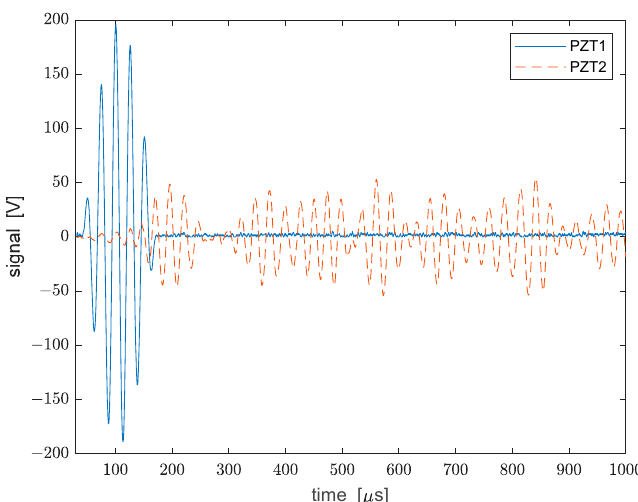
Figure 3. Excitation signal transmitted to PZT1 (blue solid line) and detected signal recorded by PZT2 (red dashed line). The detected signal from PZT2 has been multiplied by a factor of 20 for clarity.